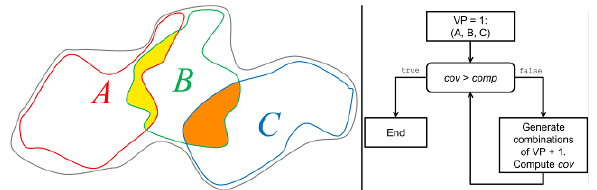
Figure 3. Example for computation of the proposed parameters (left) and flowchart of the basic algorithm